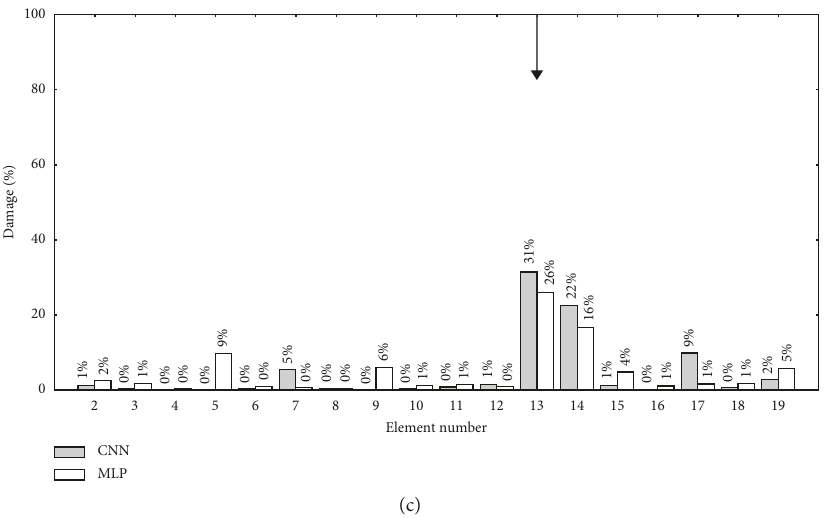
Figure 22: Results for damage scenario 2 according to (a) CNN and MLP models 1, (b) CNN and MLP models 2, and (c) CNN and MLP models